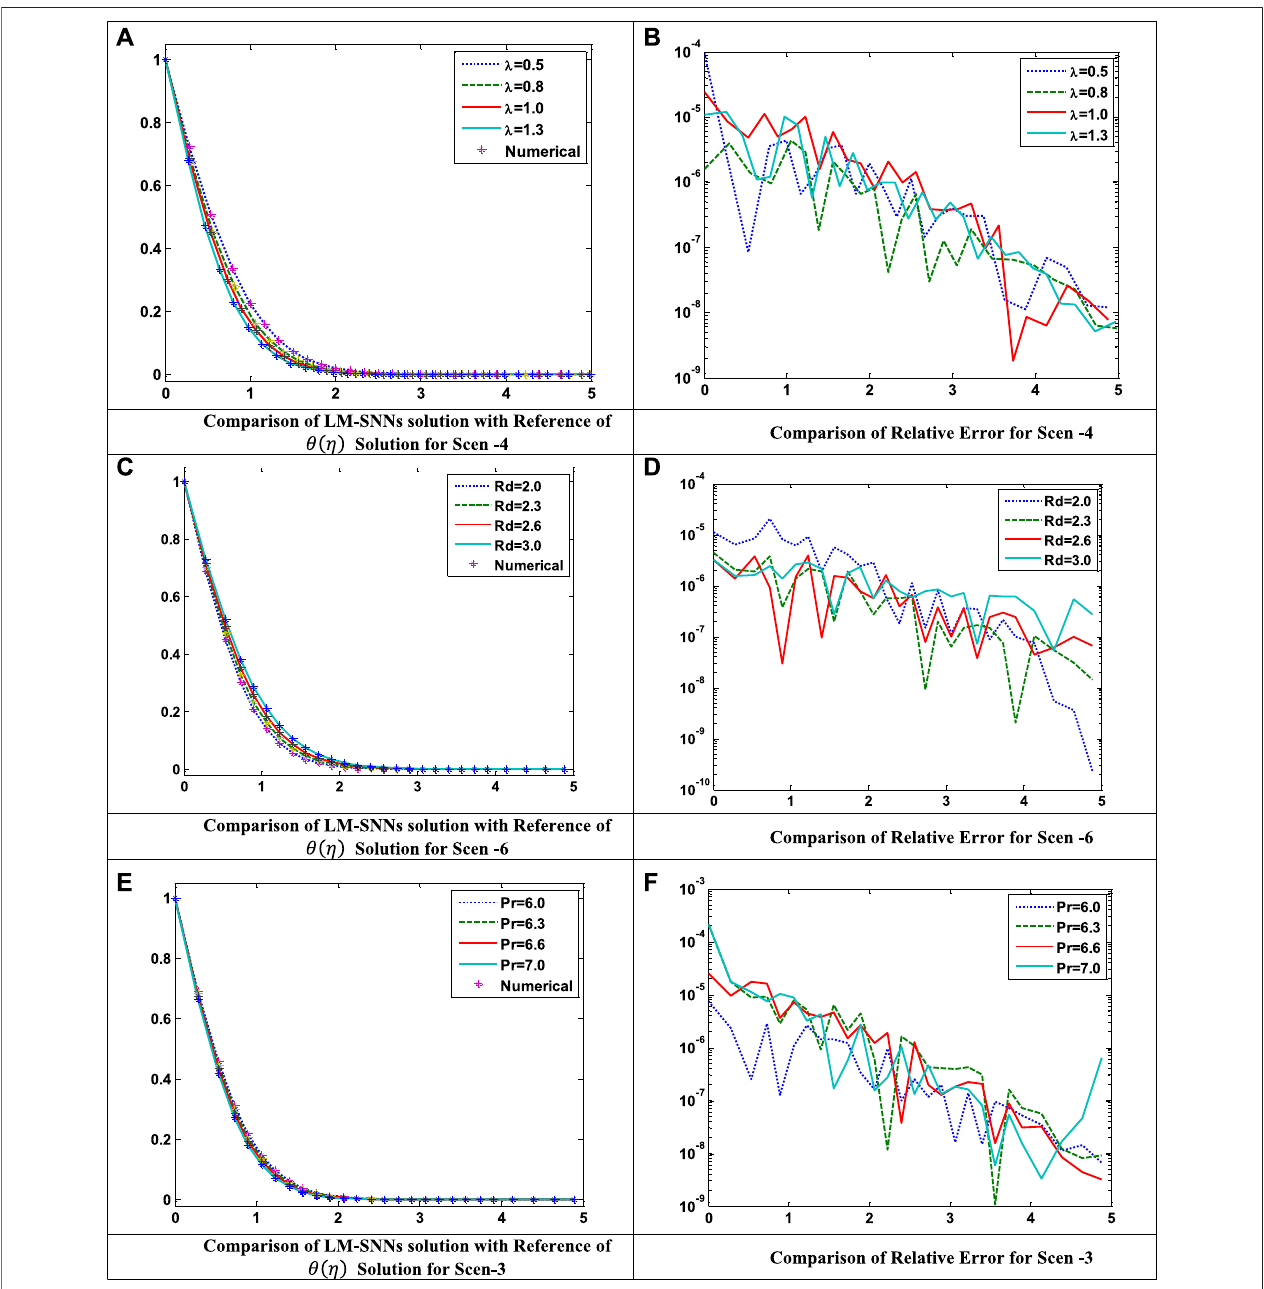
FIGURE 12 | Comparison of the Levenberg – Marquardt supervised neural network solution with reference solution along with relative errors for various scenarios. (a), (b).